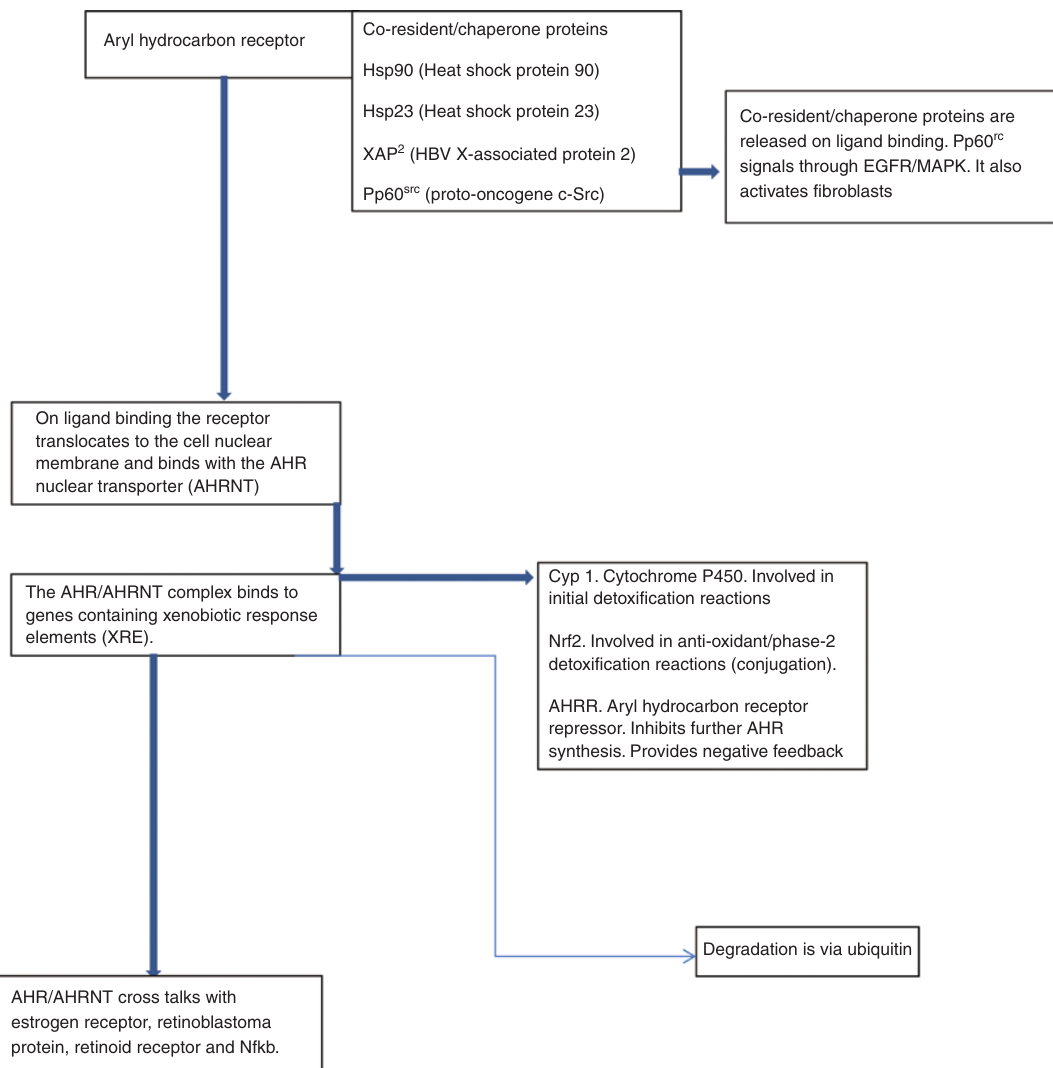
Figure 1: Schematic diagram of the aryl hydrocarbon receptor and its co-resident/chaperoning proteins outlining the mechanisms of